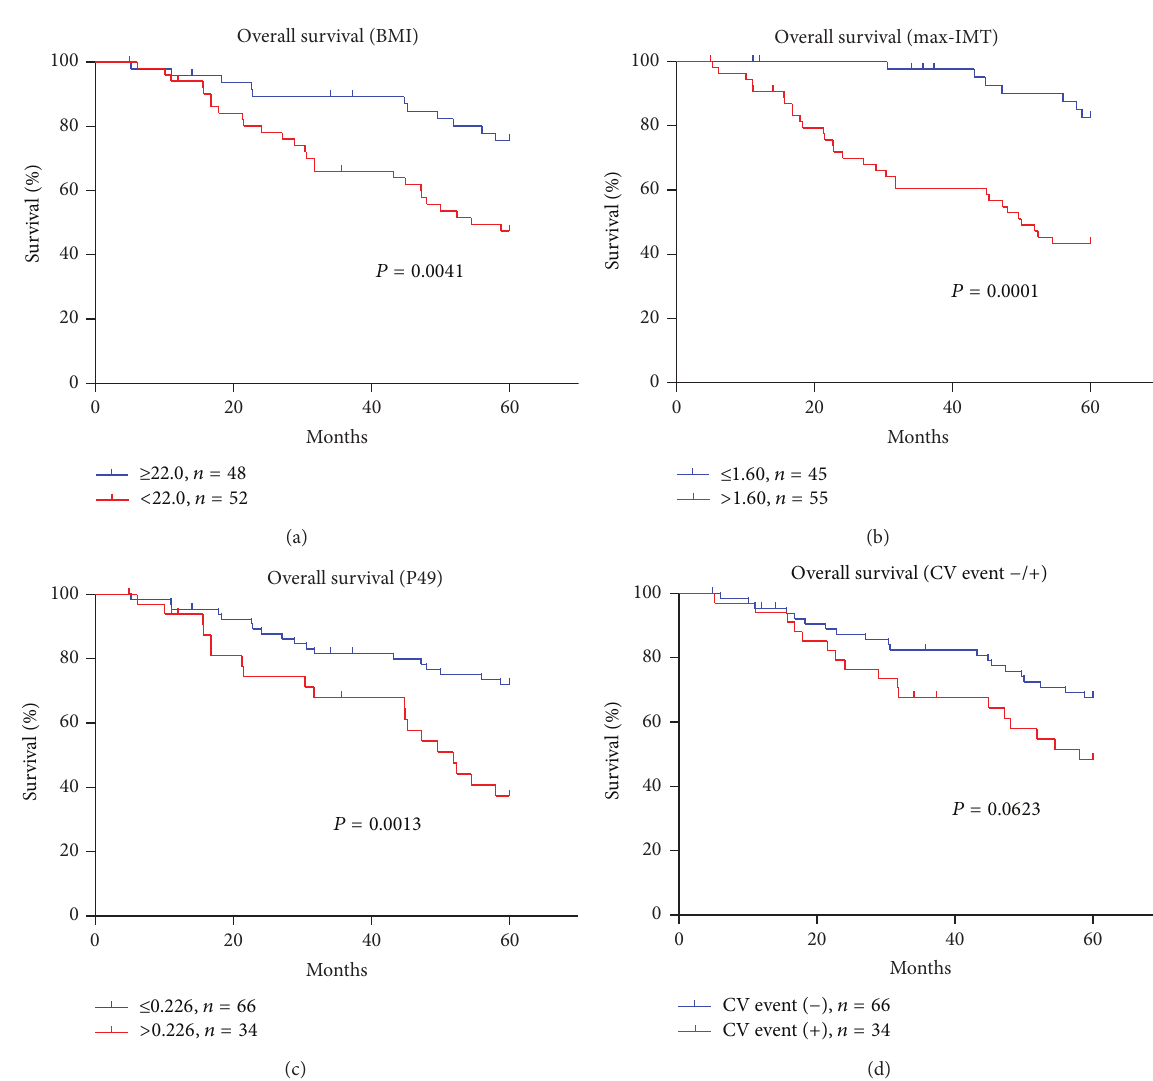
Figure 5: Overall survival from the cutoff points. Significantly poor overall survival was observed in patients with BMI < 22.0 (a), max- IMT > 1.6 (b), and P49 > 0.226 (c) using the log-rank test and the Kaplan-Meier method. Overall survival in patients with cardiovascular events showed not significant but boundary effects on prognosis ( 𝑃 = 0.0623 )